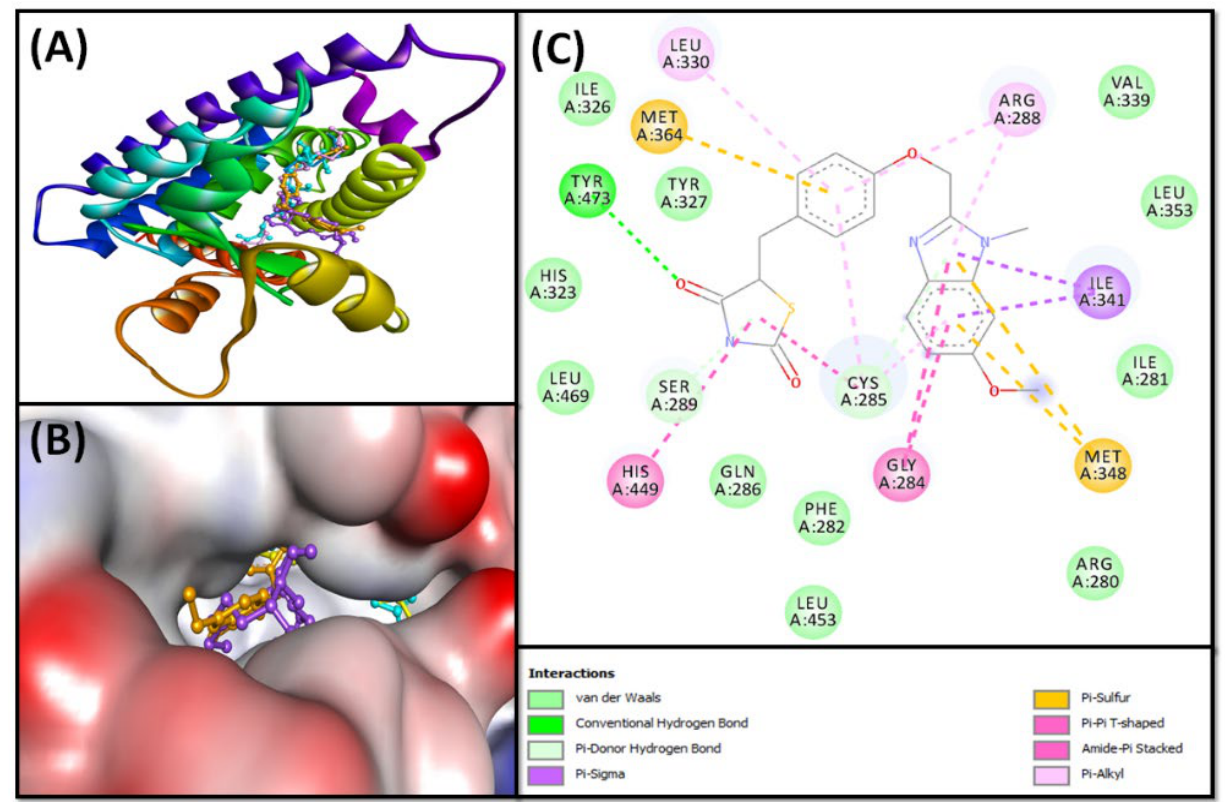
Figure 3. Molecular docking of isolated SI fatty acids and rivoglitazone (control) with PPAR- γ. ( A ) Two-dimensional representation of ligands binding to the protein; ( B ) three-dimensional represen- tation of ligands binding at the cavity of the protein; and ( C ) molecular interaction and the amino acid residues involved in stabilizing rivoglitazone (control) and PPAR- γ complex formation. The analysis revealed that the PPAR- γ –rivoglitazone complex was stabilized by hy- Table 2. Molecular docking parameters for the interaction of isolated SI fatty acids ( 1 – 4 ) with PPAR- drophobic bonding (Figure 3A,B), including two Pi-Sigma hydrophobic bonds with ILE 341 γ. and three amide-Pi-stacked interactions with GLY 284 (two interactions) and CYS 285 (one in- teraction). Further, there were five Pi–Alkyl hydrophobic interactions with CYS 285 (two